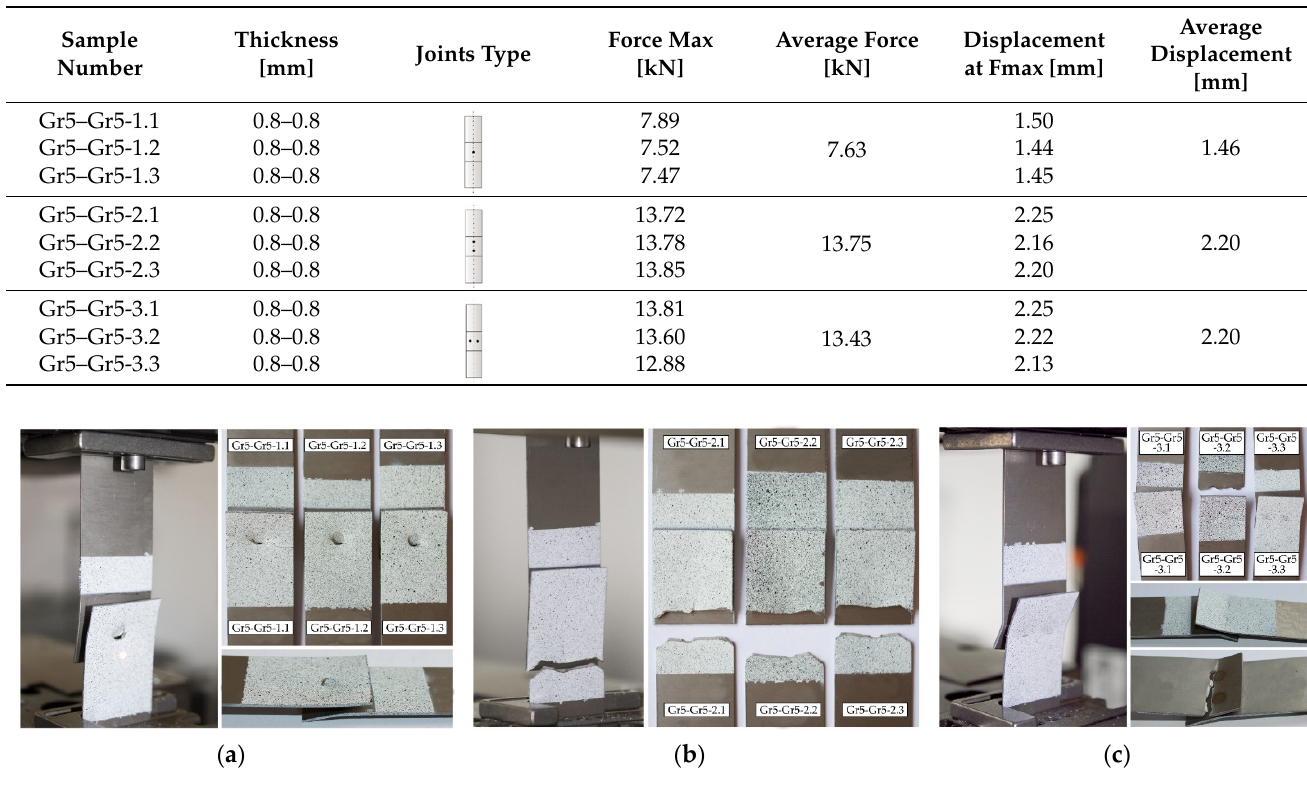
Figure 7. The method of failure of titanium samples in a tensile shear test: ( a ) with a single weld— Gr5–Gr5.1; ( b ) with two welds arranged parallel to the direction of tensile shear—Gr5–Gr5.2 and ( c ) with two welds arranged perpendicular to the direction of tensile shear—Gr5–Gr5.3.